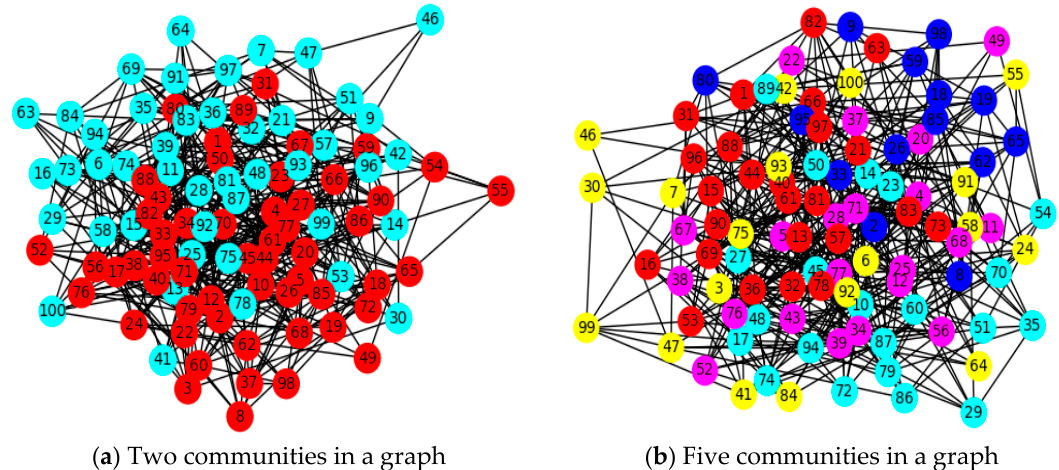
Figure 24. Examples of the detected communities from a graph of 100 nodes in a SN.